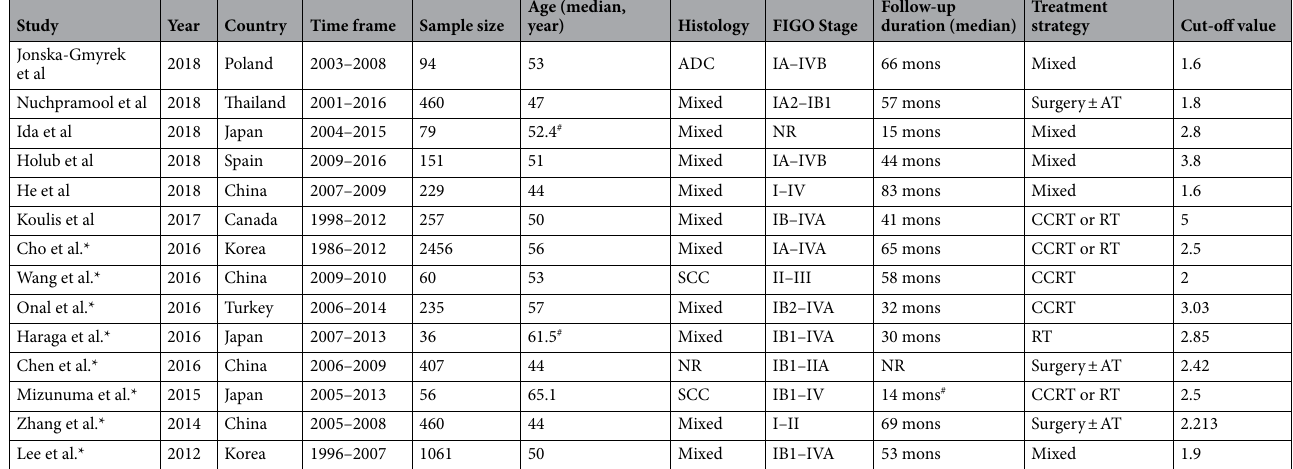
Table 1. Characteristics of included studies. NR not reported, ± AT with/without adjuvant therapy, CCRT cisplatin-based concurrent chemoradiotherapy, RT radiotherapy, ADC adenocarcinoma of cervix, SCC squamous carcinoma of cervix, FIGO International Federation of Gynecology and Obstetrics. # Mean age of the sample. # Mean follow up duration of the sample. *Included in previous meta-analysis.